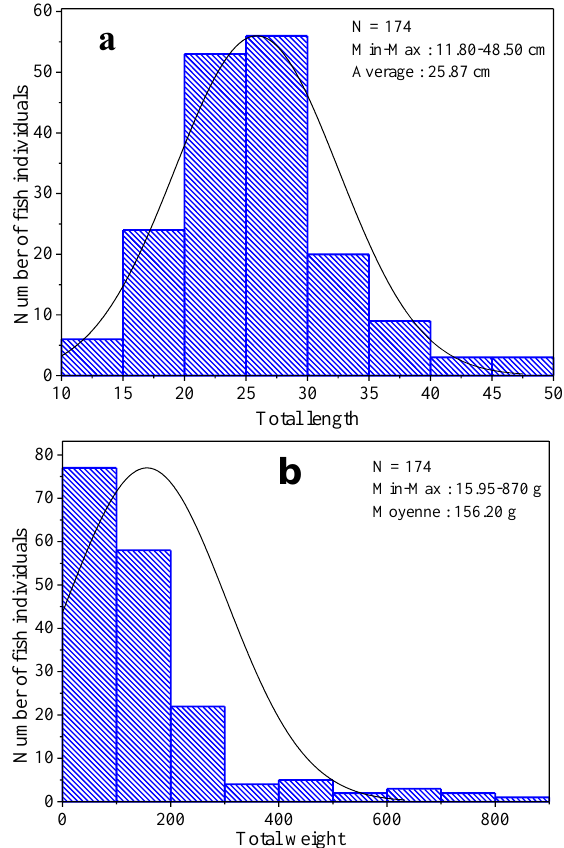
Figure 2. Frequency histograms of fish total lengths ( a ) and total weights ( b